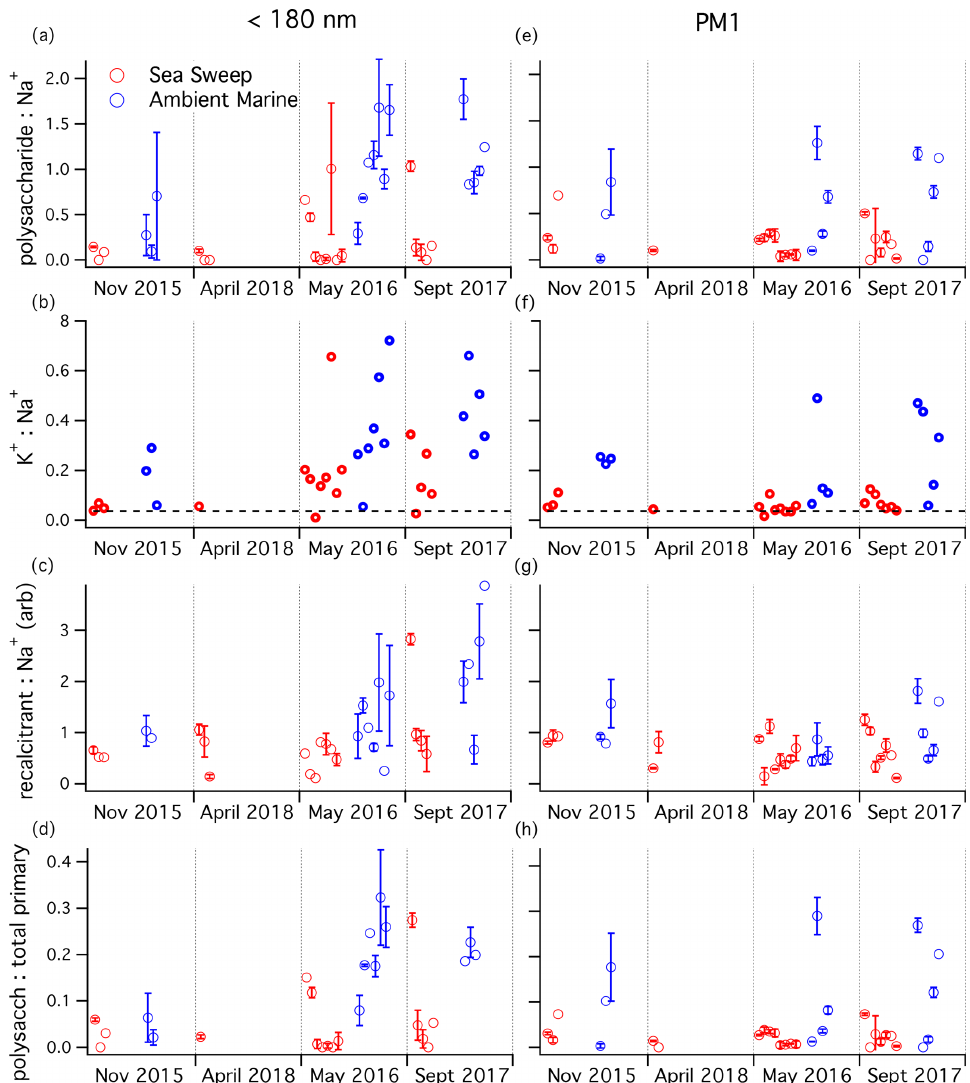
Figure 5. Aerosol component ratios for samples taken over the four NAAMES cruises, organized by season: (a, e) polysaccharide : Na + mass ratio, (b, f) K + : Na + mass ratio (seawater ratio of 0.036 plotted as dashed line), (c, g) recalcitrant factor : Na + (arbitrary unit ratio), and (d, h) polysaccharide mass : estimated total primary mass ratio. Plots (a–d) are for sub-180nm samples; plots (e–h) are for submicron samples. Any negative (below background) signals were removed from the analysis. One-standard-deviation error bars are plotted for samples with replicate runs on